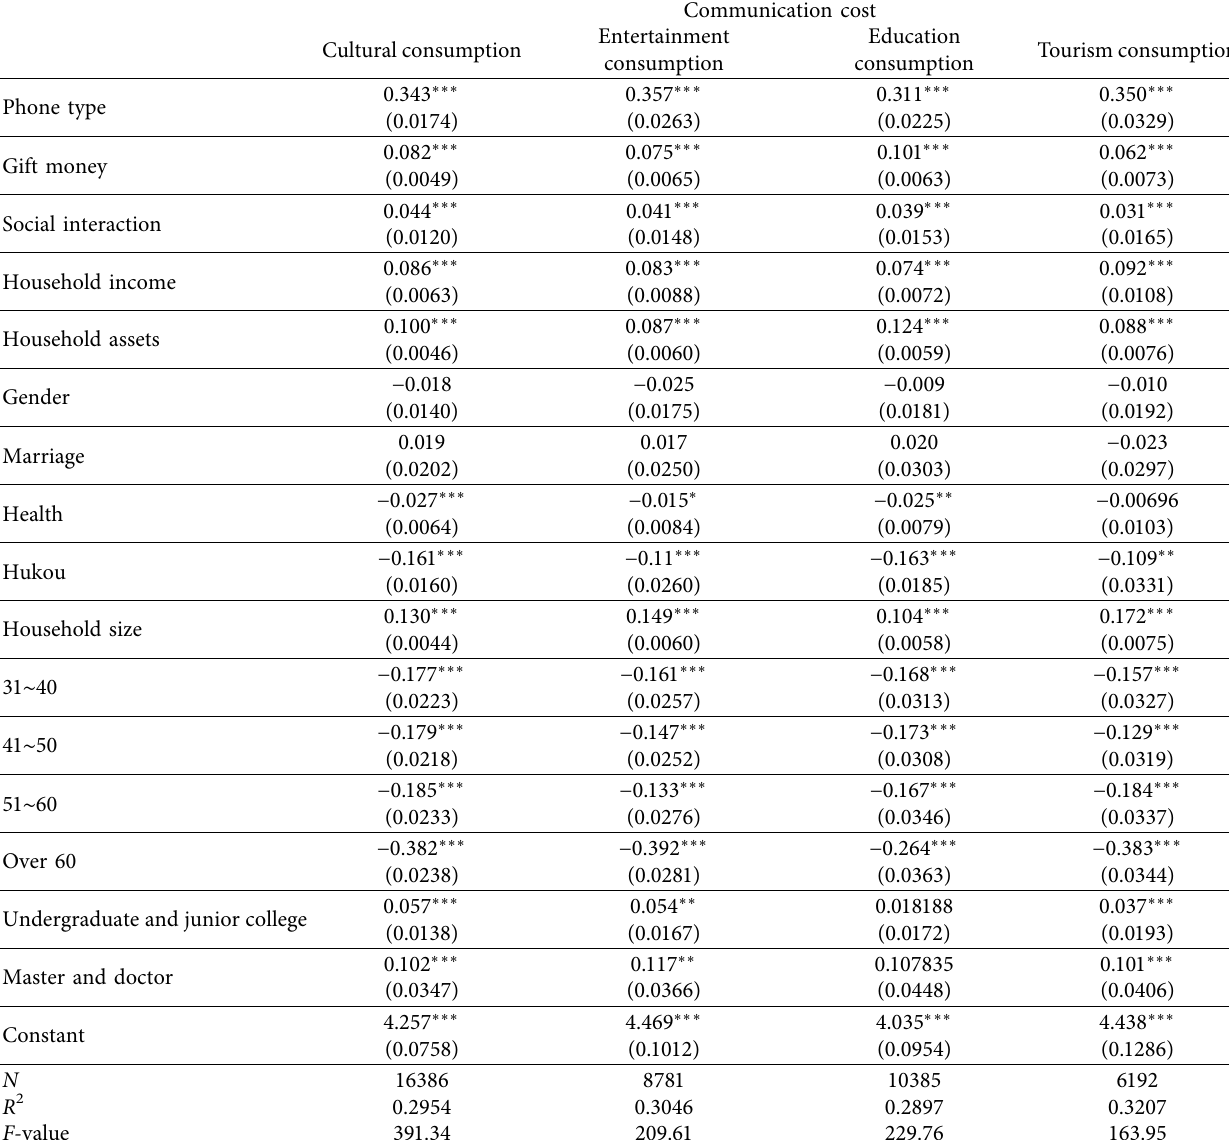
Table 6: First-stage regression of instrumental